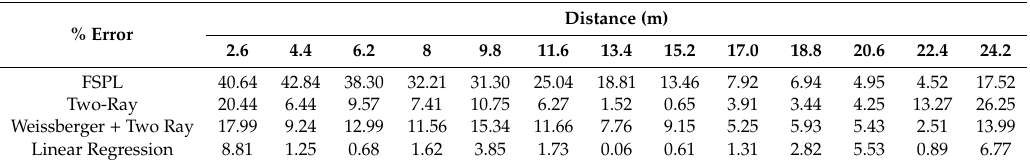
Table 4. Percentage of error in the 2.4 GHz band with propagation models in the presence of